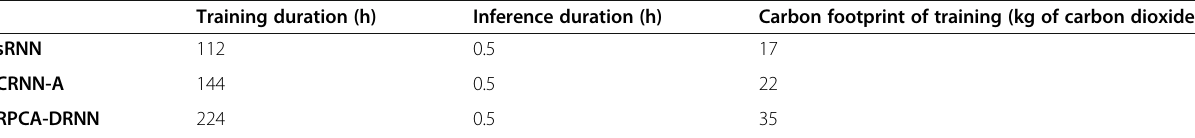
Table 6 The training duration, inference duration, and carbon footprint of training on MIR-1K of RPCA-DRNN and reference methods